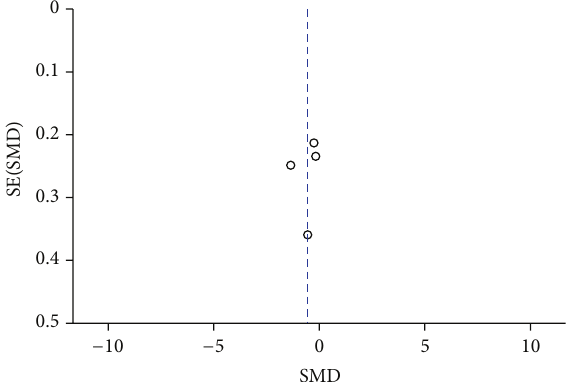
Figure 14: Funnel plot of CSF 𝛼 -syn levels in PD compared to MSA.